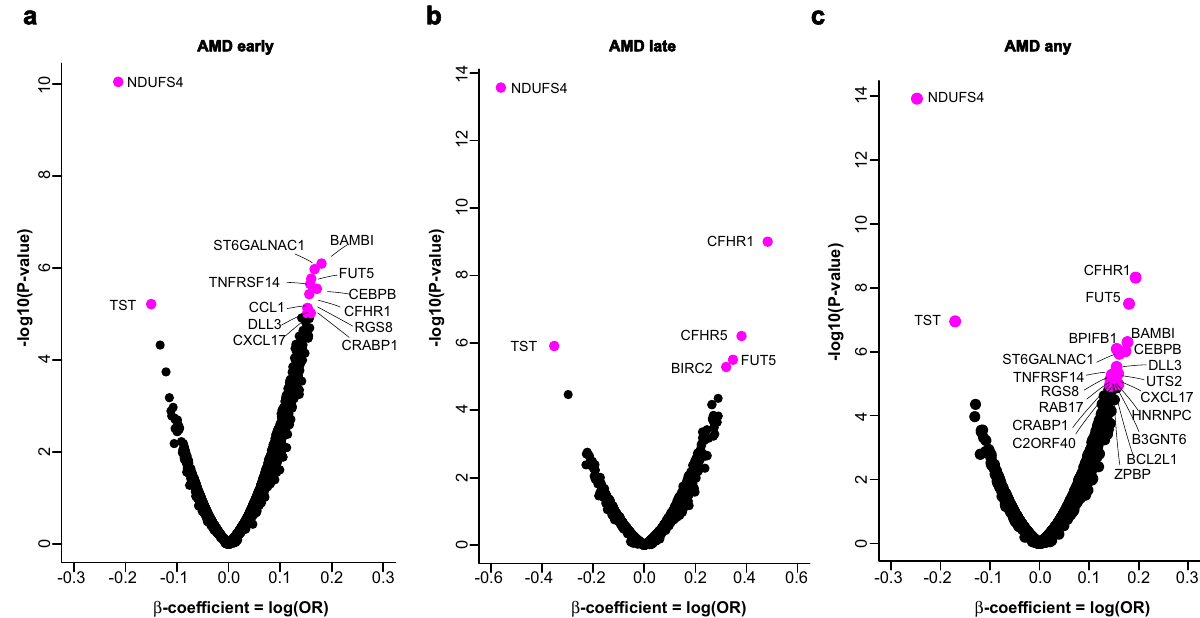
Fig. 1 Association of global serum proteins with different stages of AMD. a A volcano plot of all serum proteins associated with AMD early is shown using logistic regression analysis and Bonferroni correction for multiple comparisons, with colored (magenta) data points highlighting study-wide signi fi cant associations ( P < 1.21 × 10 − 5 , two-sided). De fi nition of early-stage AMD was according to Holliday et al. 22 . b Similar analysis and representive volcano plots of late-stage AMD, and c for AMD any (early and late stage AMD), where early-stage of the disease was de fi ned according to Holliday et al. 22 . The y-axis represents the -log 10 ( P -value) of associations (linear regression), while the x-axis represents the estimate as beta-coef fi cient = log(odds highest levels of PRMT3 (F-test P = 0.001). No baseline protein